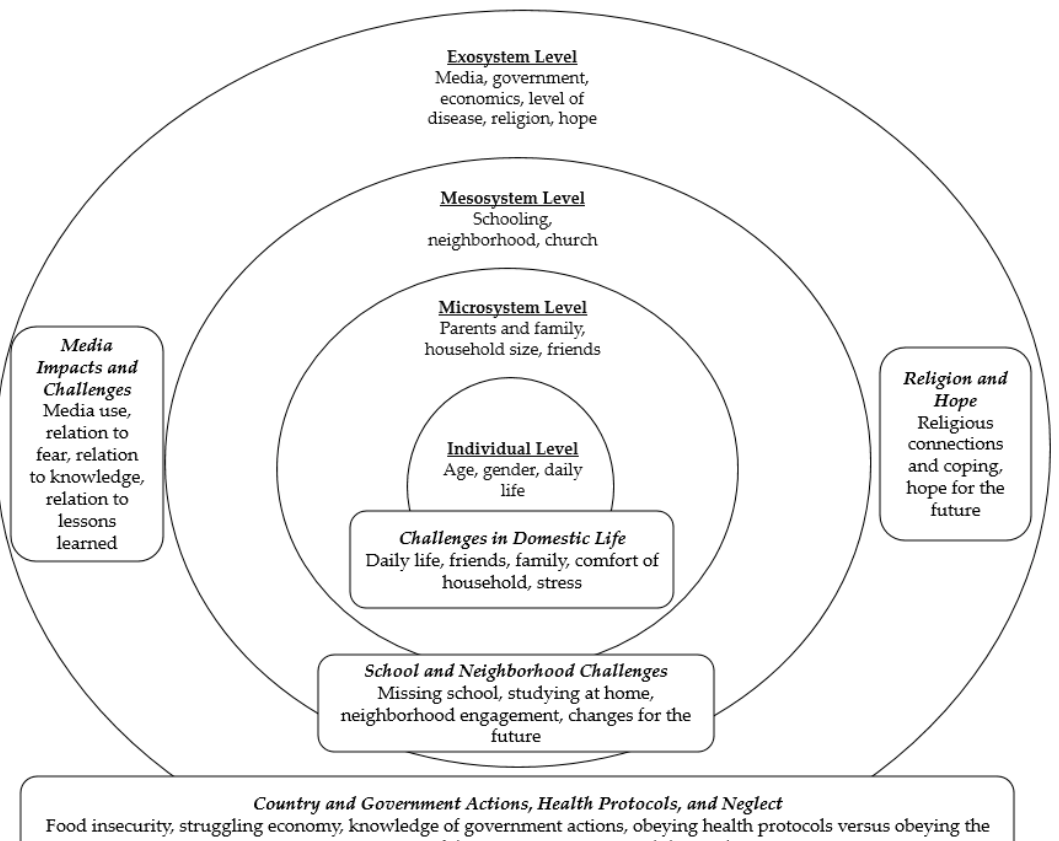
Figure 1. Coding diagram, including major themes and subthemes by ecological systems theory level.